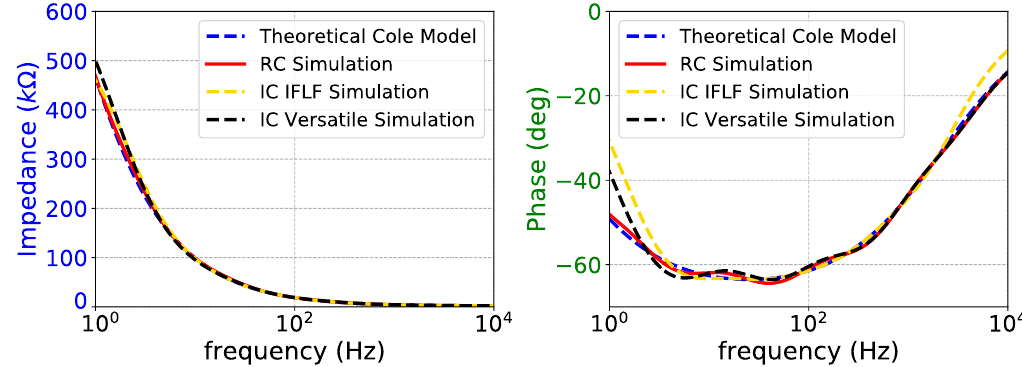
Figure 14. Impedance magnitude ( left ) and phase response ( right ) of fractional-order skin